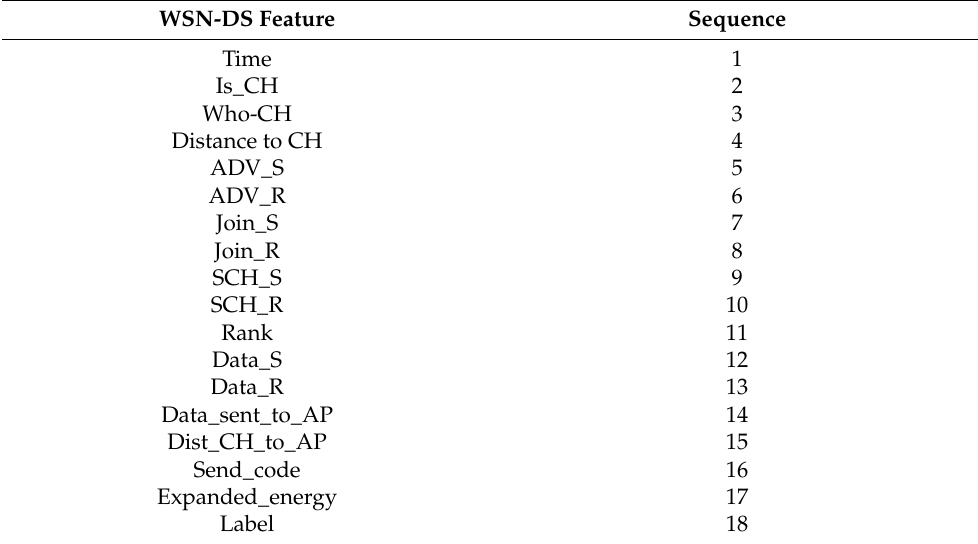
Table 3. WSN-DS Features